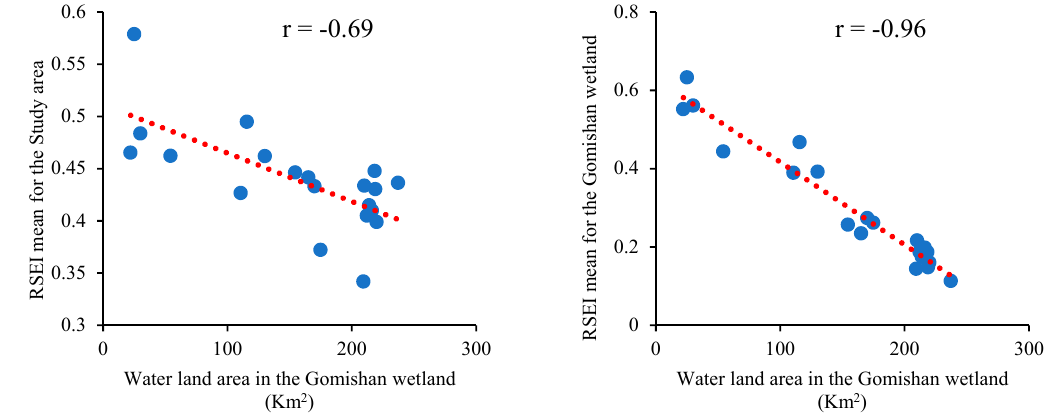
Figure 14. The r between the water land areas in the Gomishan wetland and the RSEI means for the Gomishan wetland and the study area between 1987 to 2017.